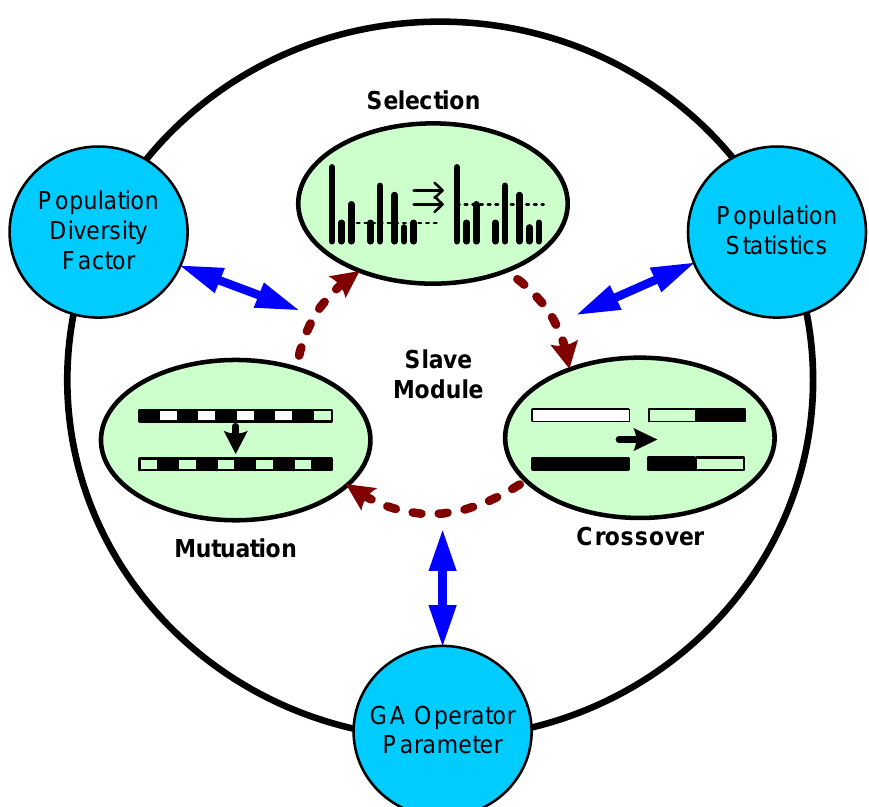
Figure 15. Adaptive genetic algorithm (GA) model organization (adapted from [203]).